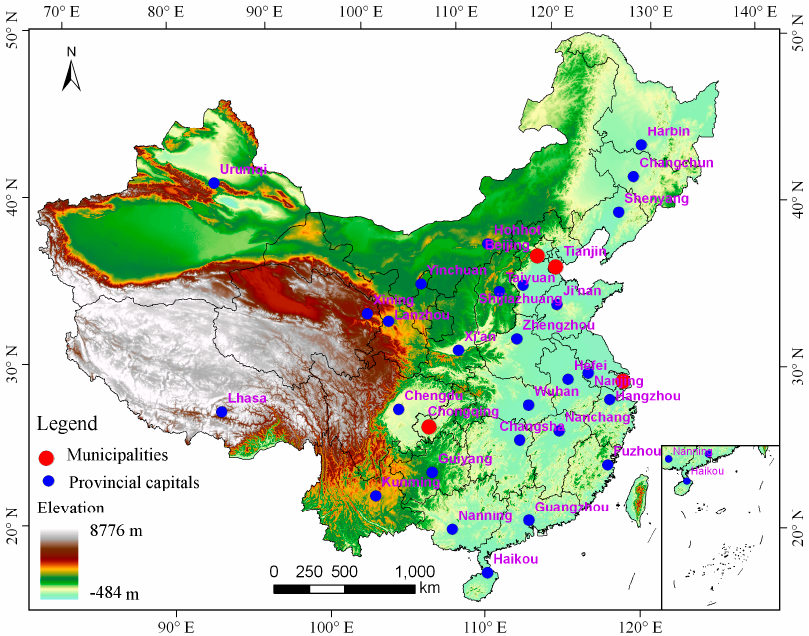
Figure 1. The location of the 31 sample cities in China. Notes: The elevation levels of China was acquired from the Advanced Spaceborne Thermal Emission and Reflection Radiometer Global Digital Elevation Model (ASTER GDEM), ranging from − 484 m to 8776 m in land area.